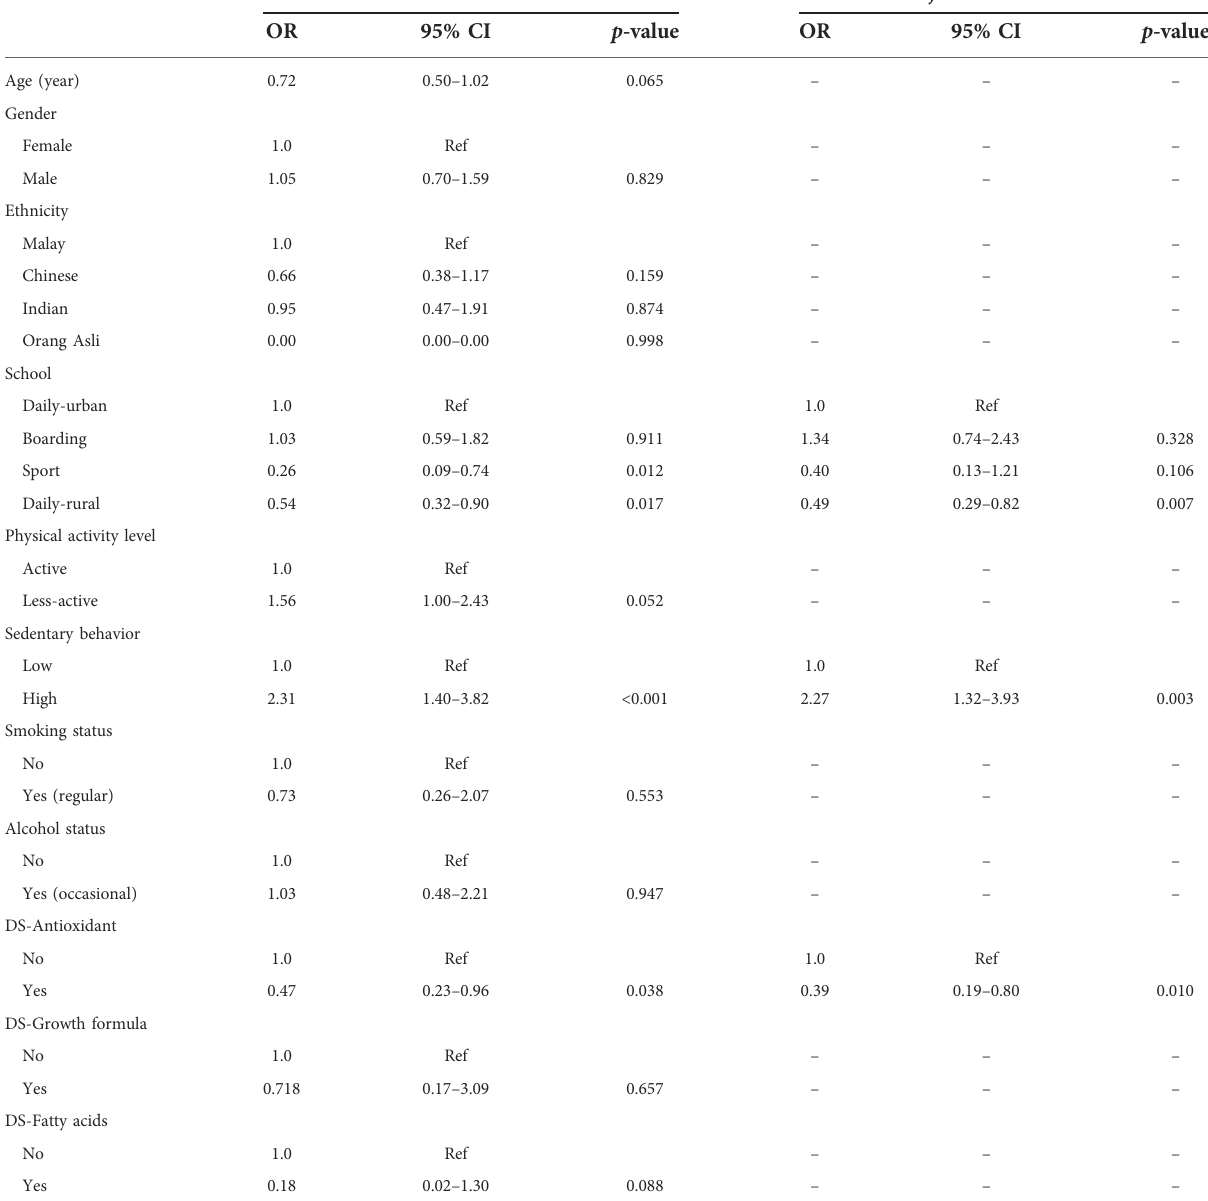
TABLE 6 Logistic regression analyses for factors associated with the risk of obesity a ( n